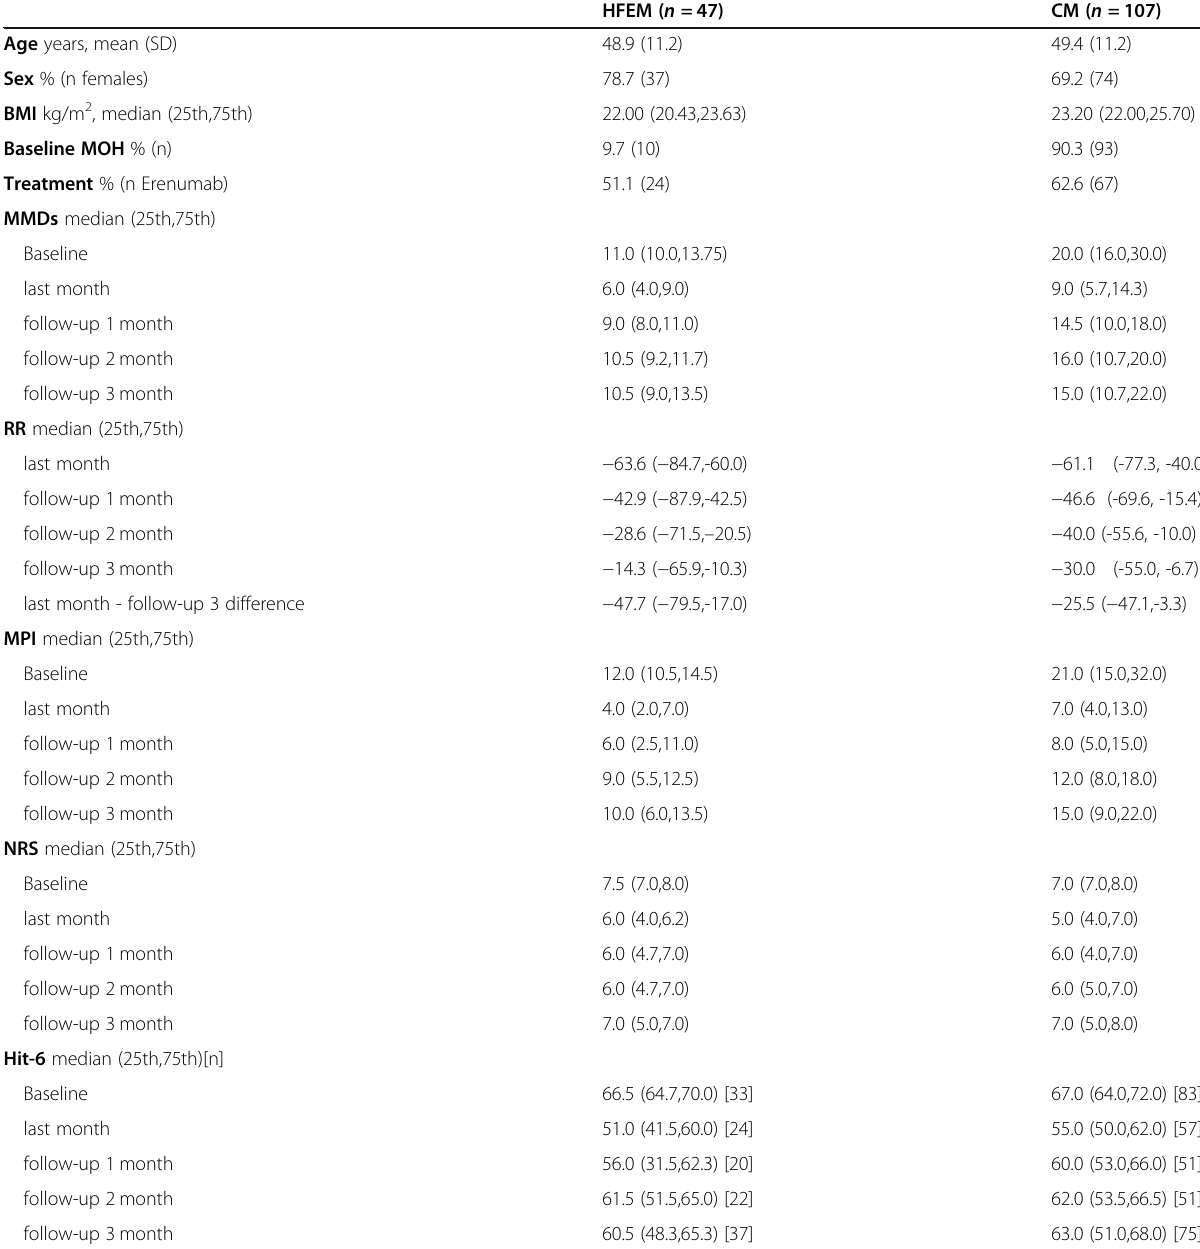
Table 1 Demographical profiles and clinical variables at evaluation times in HFEM and CM